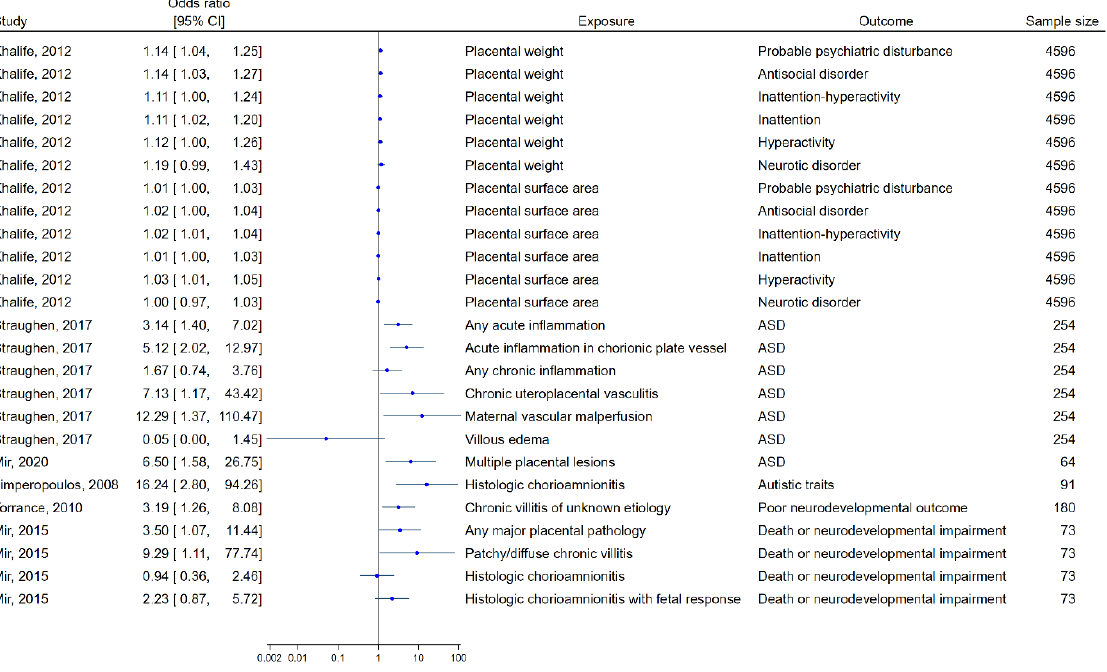
Figure 2. A forest plot detailing the risk (odds ratios (95% CI)) for different poor neuropsychological outcomes in childhood after the exposure of different placental changes (i.e., placental size or patho- logical lesions found at birth) as reported in six studies included in the review. The studies by Khalife et al. and Straughen et al. were mainly performed on full-term born children [63,65], while the other studies only were performed on children with a complicated neonatal period.